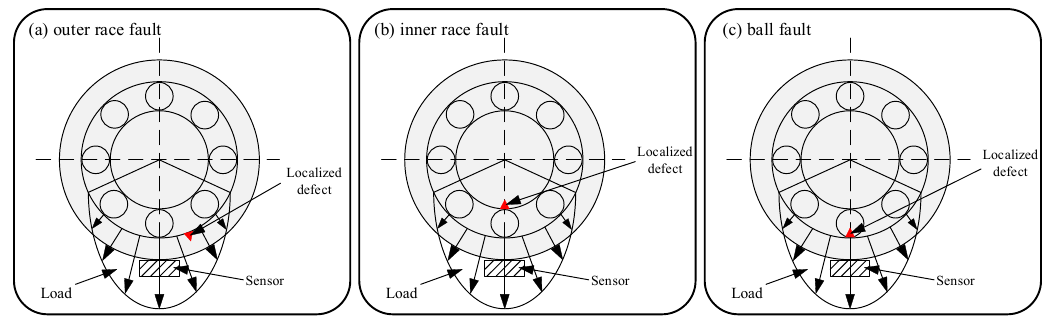
Figure 2. The overall fault diagnosis framework.